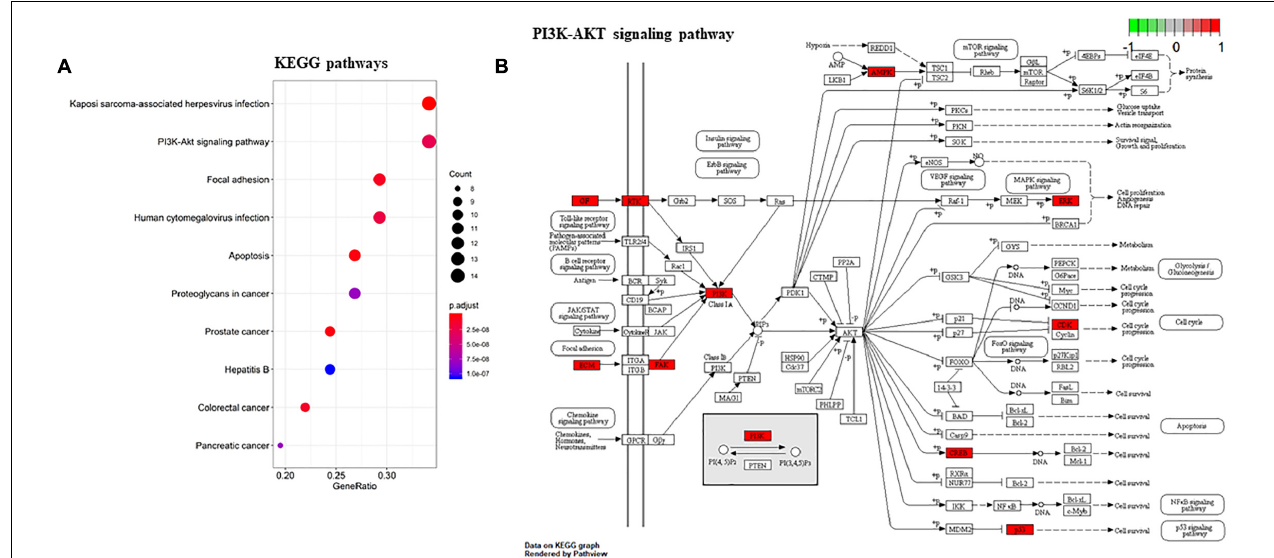
FIGURE 6 | KEGG enrichment analysis of the quercetin target genes. (A) KEGG annotation of target genes. The number of genes enriched in each KEGG term is shown as the circle size, the p -value shown as different colors. (B) The important genes were mainly distributed in the PI3K–AKT signaling pathway. Arrows represent activation effect, T-arrows represent inhibition effect and segments show activation effect or inhibition effect. The red nodes are the intersection genes.